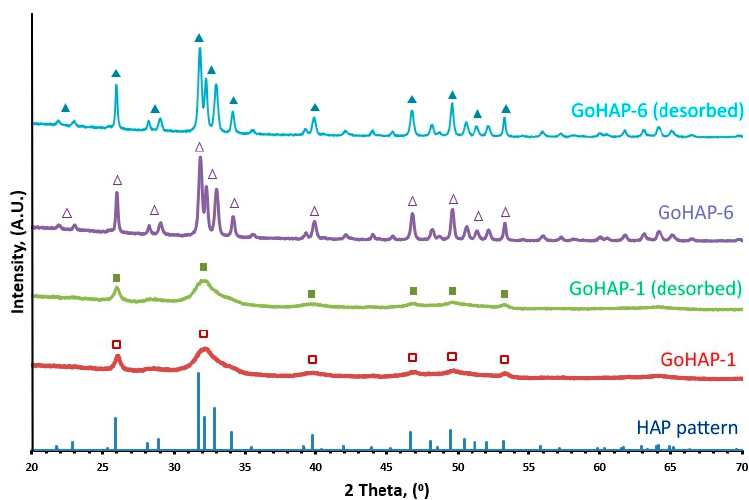
Figure 1. X–ray diffraction line profiles of GoHAP™ with particle sizes of 10 nm and 40 nm before and after desorption.